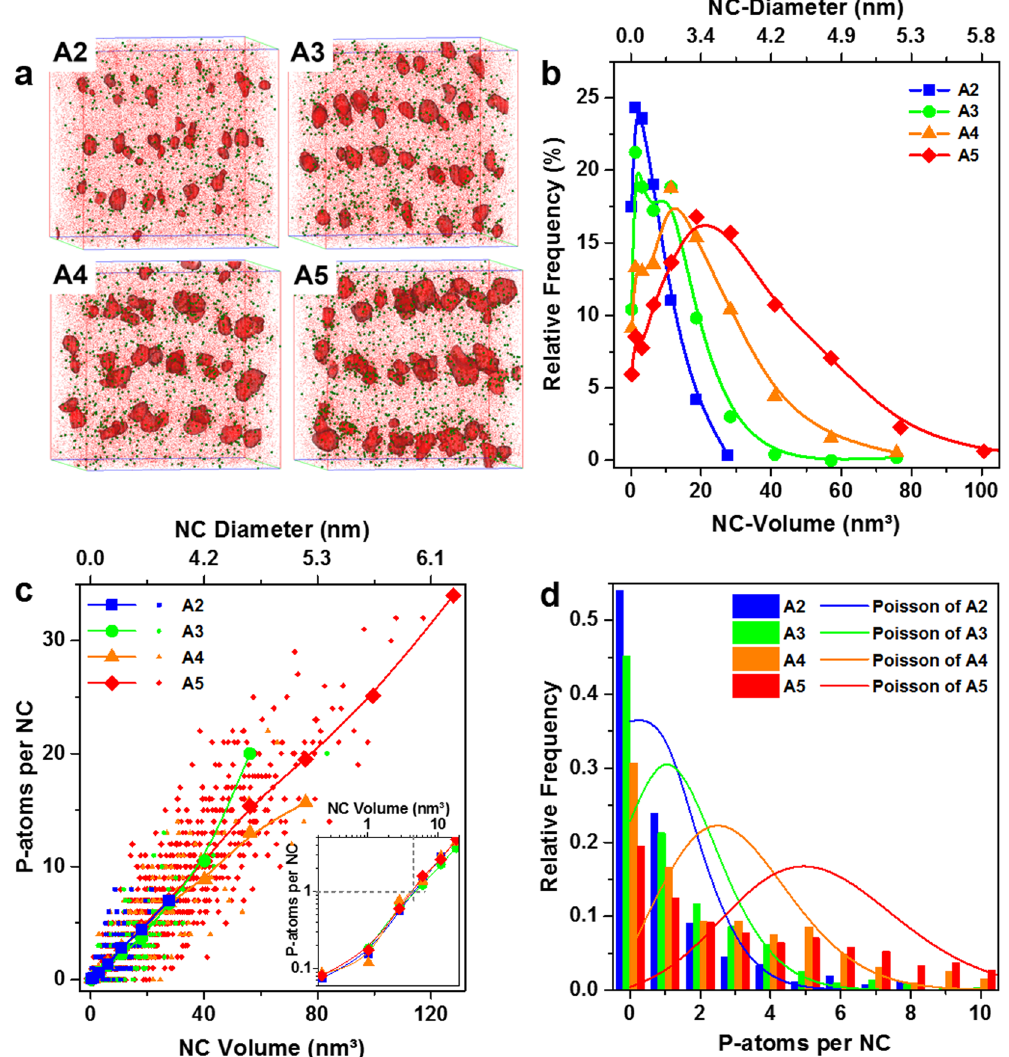
Figure 1. Atom probe tomography analysis. ( a ) APT-reconstructions with Si NCs depicted as red Si iso- concentration surfaces ( ≥ 70 at%), Si-atoms in red and P-atoms in green. ( b ) Frequency distribution of the Si NC volumes of each sample, the solid lines (splines) are just a guide to the eye. ( c ) The number of P-atoms per NC as function of NC volume represents an approximately linear behaviour (small symbols: APT raw data, large symbols: average values from grouping NCs in volume classes). The inset magnifies the region around one P-atom per NC. Grey dashed lines show that NCs with 1 P-atom are on average at d NC ≈ 2 nm. ( d ) Comparison of the relative frequencies of NCs with n P-atoms per NC as measured by APT (bar graph) and ideal Poisson distributions with the average number of P-atoms per NC in each sample as expected value (solid lines). Due to the NC size dispersion the distributions are clearly non-Poissonian but they can be fitted as exponential probability distributions (fits not shown for the sake of